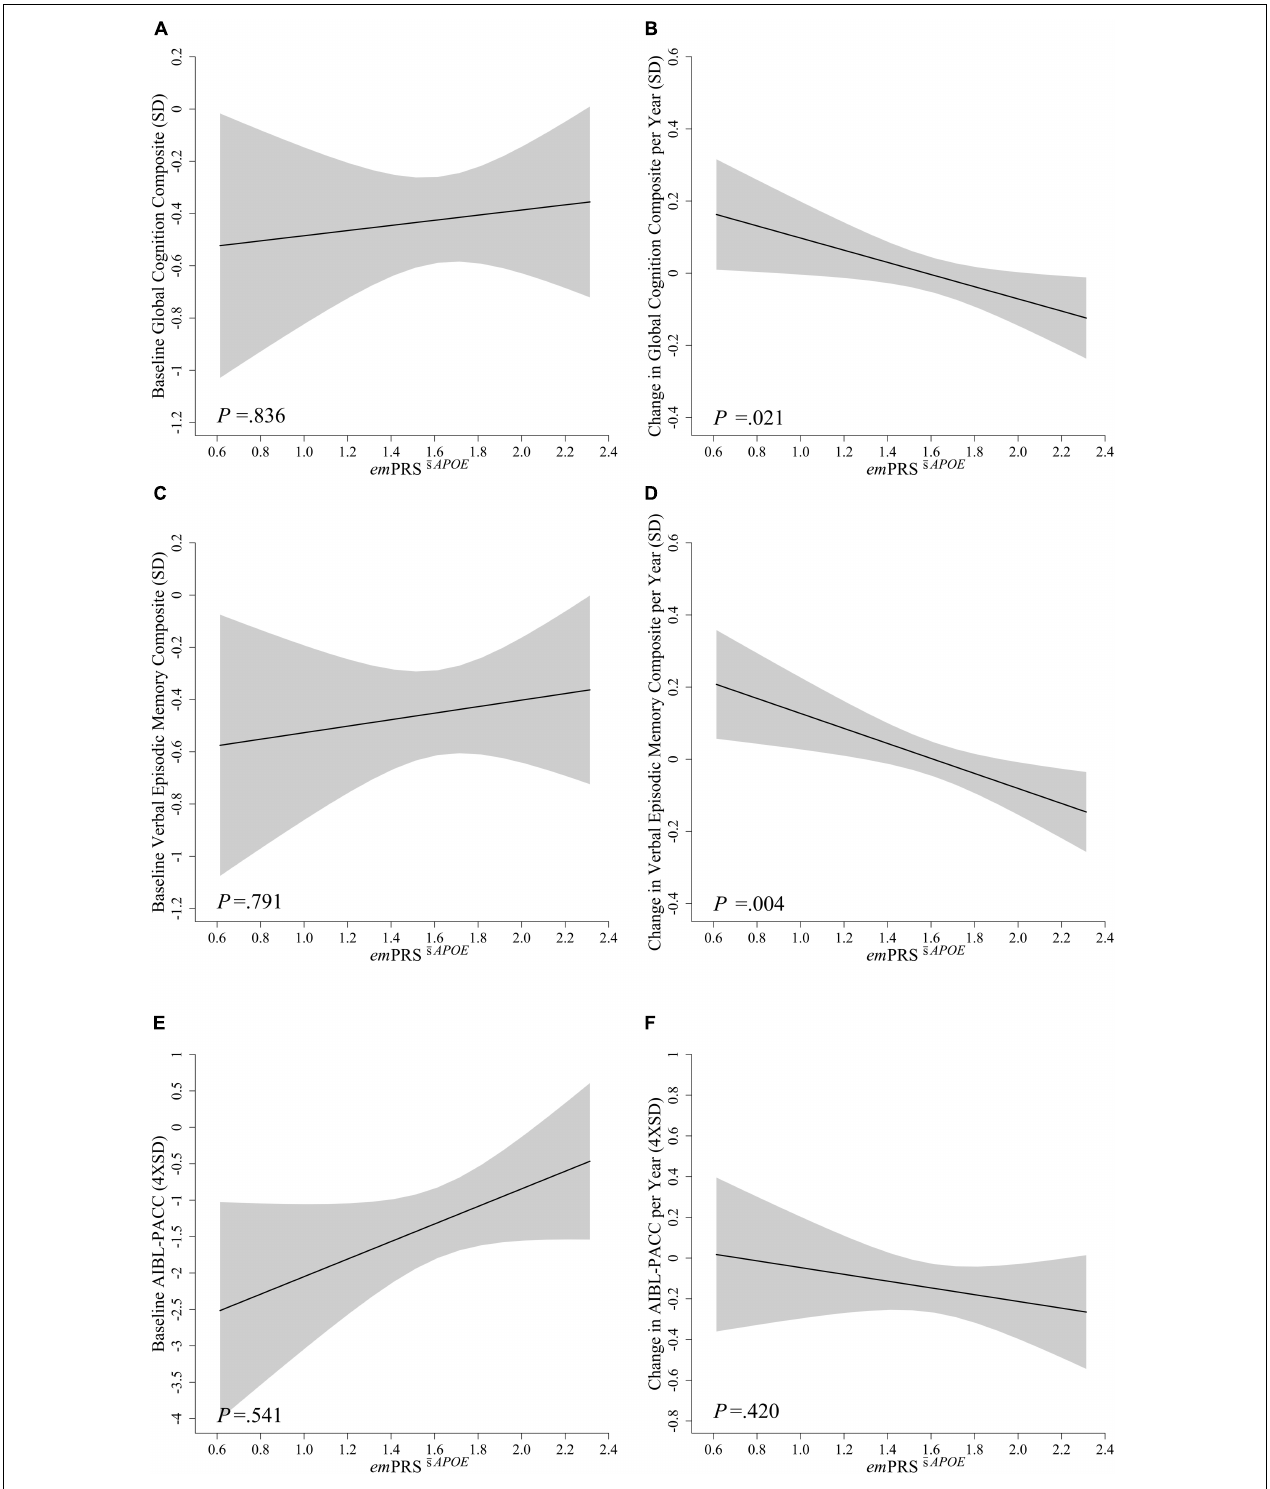
FIGURE 2 | Association between em PRS ¯ sAPOE and baseline and longitudinal change in cognition in A β high CN older adults. Association between em PRS ¯ sAPOE and baseline (A,C,E) and longitudinal change (B,D,F) in composite measures of cognition including a statistically driven global composite (A,B), verbal episodic memory composite (C,D) , and Pre-Alzheimer’s Cognitive Composite (AIBL-PACC; E,F ) in cognitively normal (CN) older adults with high A β (A β high ; n = 75). AIBL-PACC controlled for age. Shaded regions represent emPRS dependent standard error. em PRS ¯ sAPOE , cognition weighted polygenic risk score without APOE genotype.